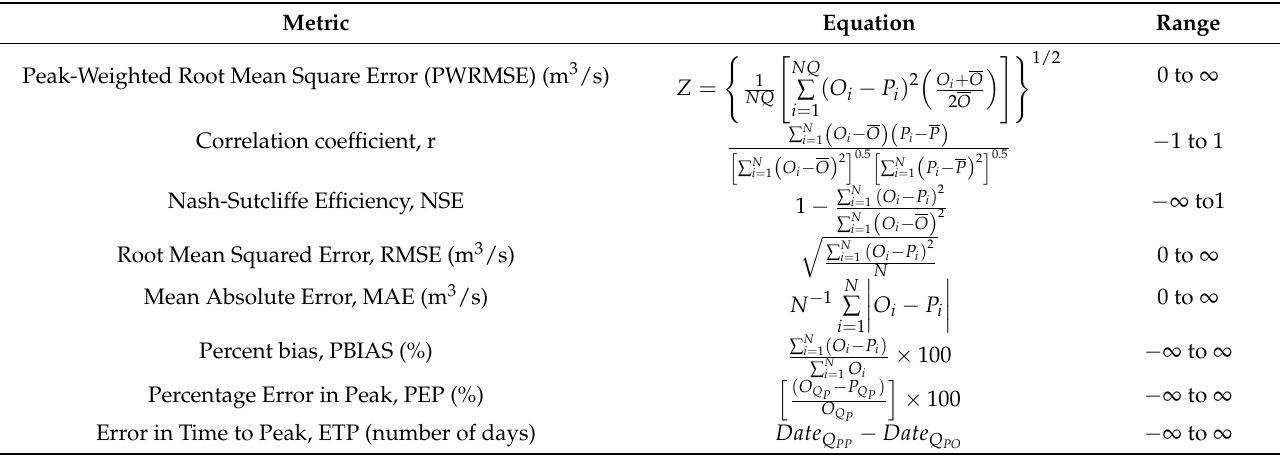
Table 4. Mathematical formulae of the objective function and verification metrics used for the model calibration. Metric Equation